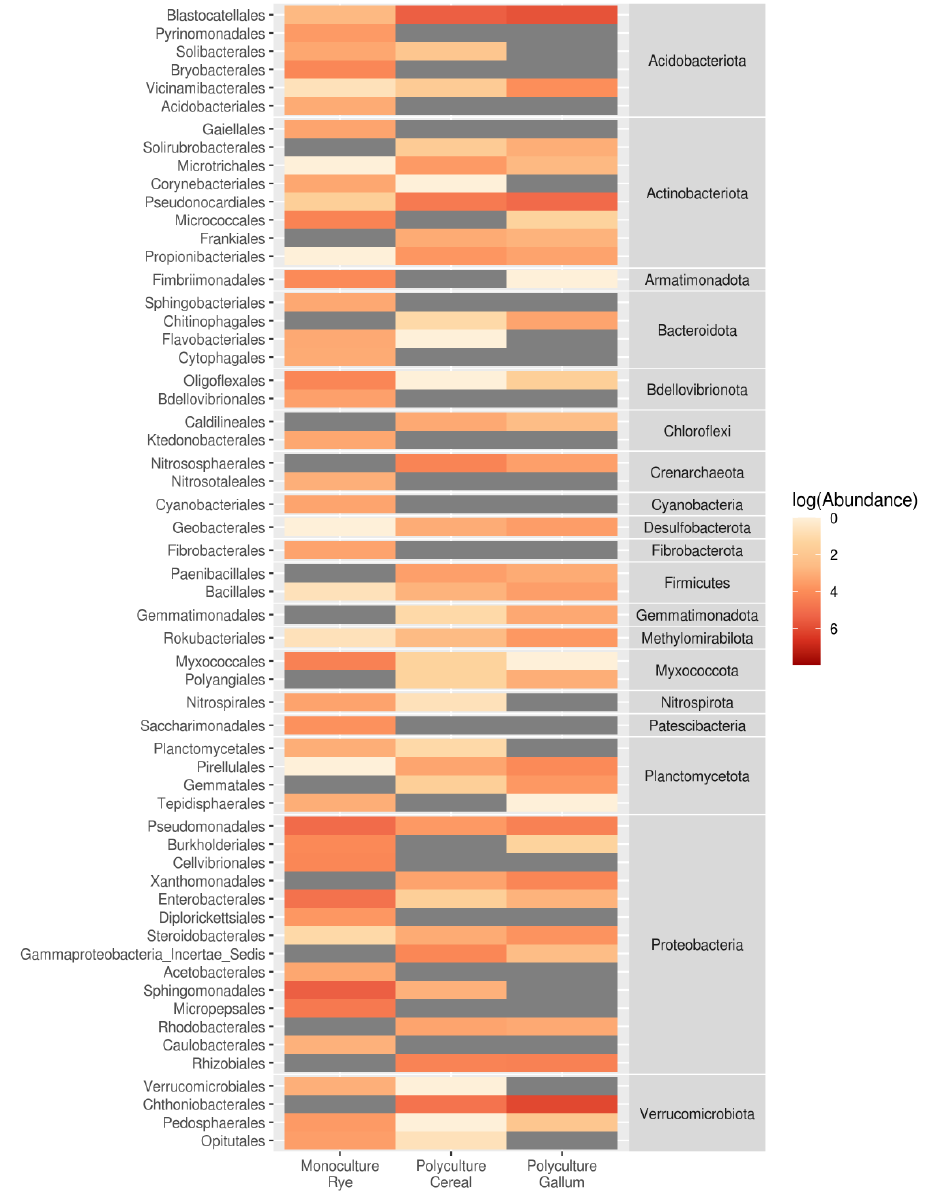
Figure 2. Mean abundances of bacterial orders with different inter-source abundances (according to DeSEQ2).